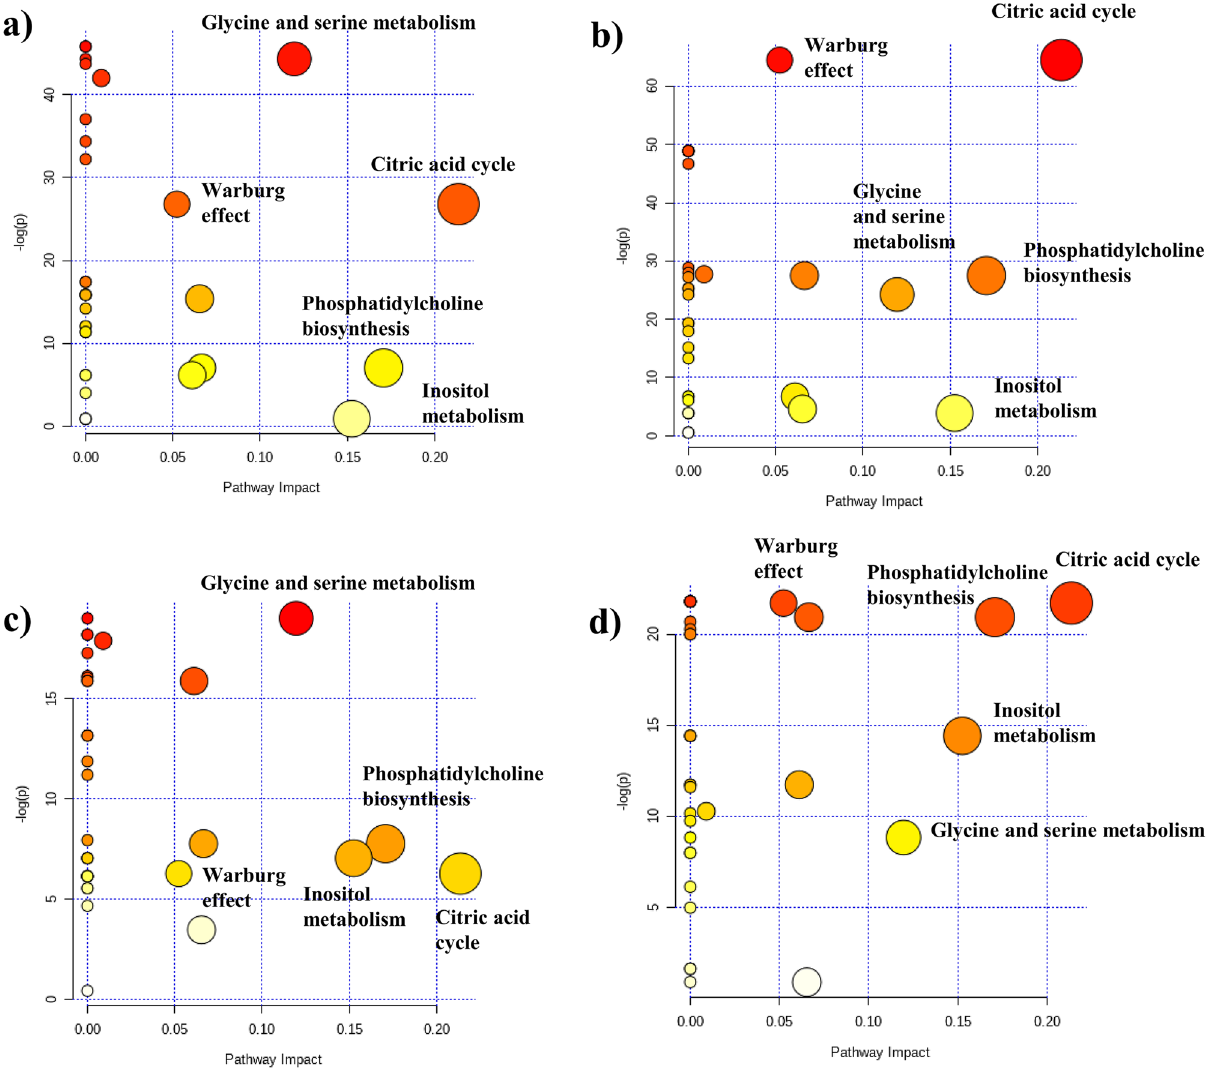
Figure 7. Metabolome views obtained from the pathways analysis presenting the pathways altered in ( a ) the malignant lesions vs. colloid goiter, ( b ) the benign lesions vs. colloid goiter, ( c ) the malignant lesions vs. chronic thyroiditis and ( d ) the benign lesions vs. chronic thyroiditis. On the y-axis, the –log (p) value represents the quantitative perturbation of pathways. On the x-axis, the pathway impact value (the score is from 0 to 1) refers to the centrality of a metabolite in the metabolic network. The node color, varying from yellow to red, is based on its p value, and the node radius is determined on the basis of their pathway impact values. Only pathways with p < 0.05 and/or pathway impact value > 0.10 are considered. The image was created using Metaboanalyst 4.0 software. https ://www.metab oanal results obtained from the SUS plots: in the SUS plot 1 (where the malignant and benign lesions vs. colloid goiter are shown) citrate falls within the section 3 (Fig. 6a), while in the SUS plot 2 (showing the malignant and benign lesions vs. chronic thyroiditis) citrate is located near the central position of the plot (Fig. 6b), which indicates no meaning of this metabolite in distinguishing the groups involved in the comparison. The pathway corresponding to the inositol metabolism seems to be perturbed much stronger, both in the benign and malignant lesions in reference to chronic thyroiditis (Fig. 7c,d, Supplementary Table S5) than to col- loid goiter (Fig. 7a,b, Supplementary Table S5), where in case of the malignant lesions vs. colloid goiter (Fig. 7a) even the p value limit is not fulfilled (Supplementary Table S1). Similarly, no meaning of the inositol metabolism in the models differentiating malignant and benign lesions vs. colloid goiter is indicated in the SUS plot 1—as myo-inositol falls in the central area of the plot (Fig. 6a). The position of this metabolite in the section 1 of the SUS plot 2 (Fig. 6b, the malignant and benign lesions vs. chronic thyroiditis) points towards an equal role of its metabolism in the malignant and benign lesions referenced to chronic thyroiditis, thus confirming the observa- tion from the pathway enrichment analysis.